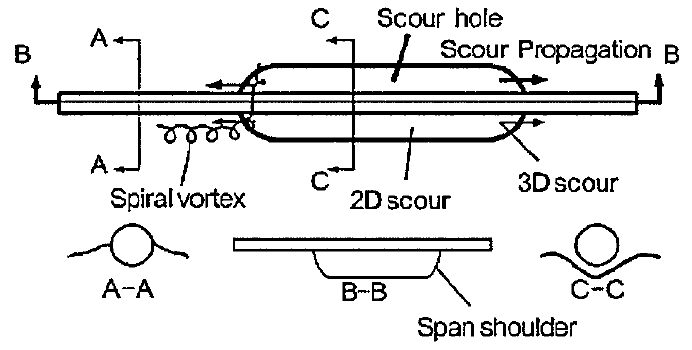
Figure 1. Three-dimensional scour process below the pipeline (PL) [18].